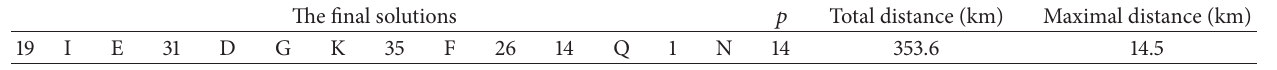
Table 3: The final solutions for the emergency facilities location